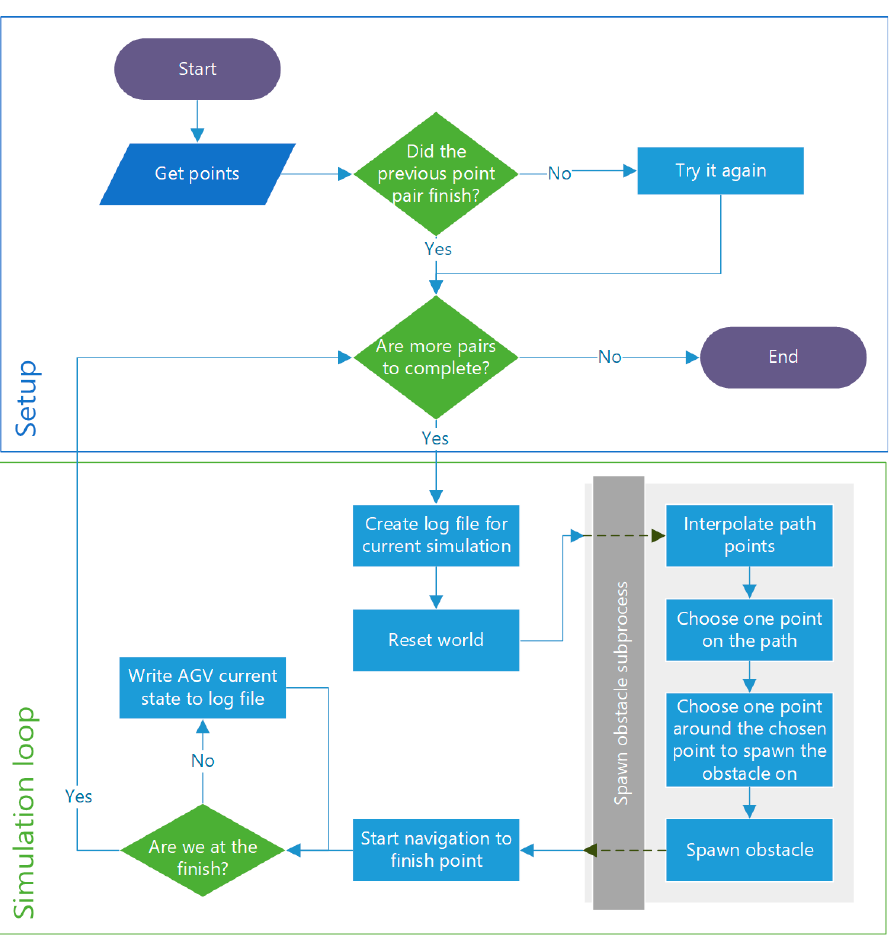
Figure 4. Automation program workflow.